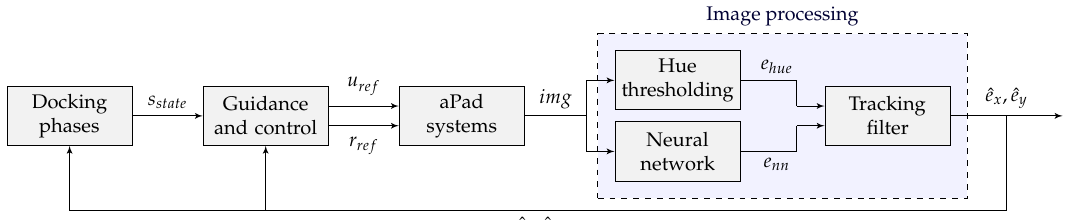
Figure 8. Control structure for autonomous docking on